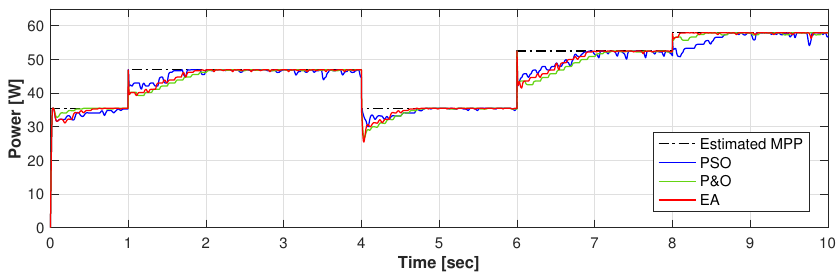
Figure 16. Power harvested through time, regarding the low power simulation.